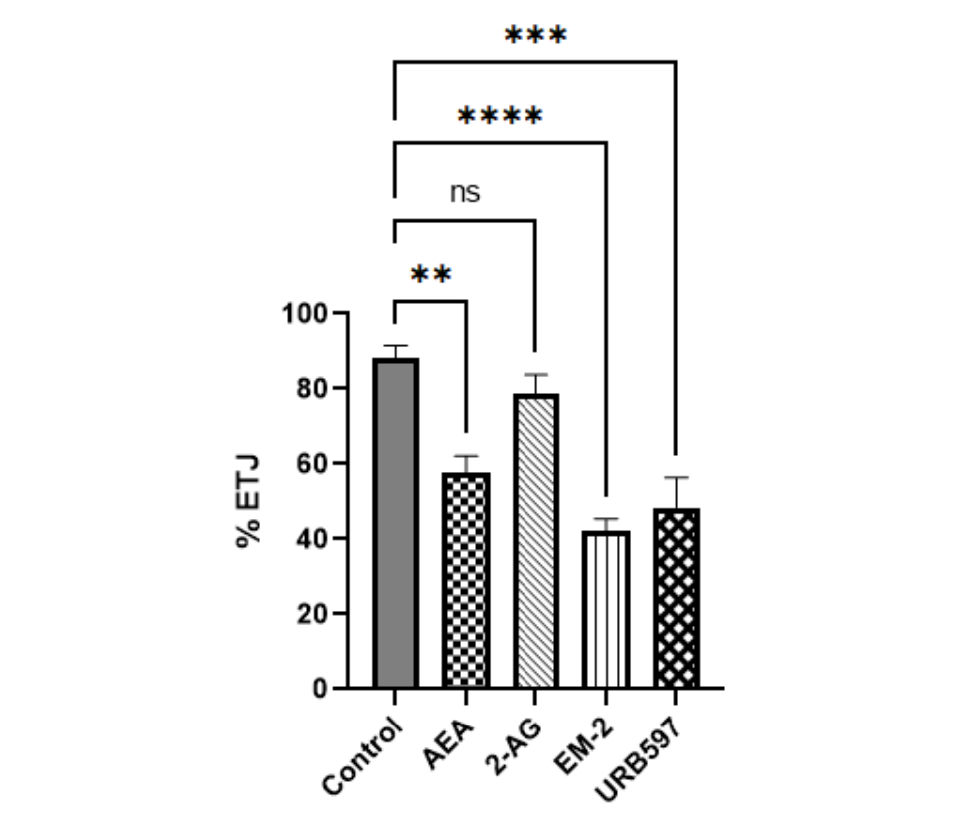
Figure 1. Effects of perfusion of cerebral ventricles with aCSF and with AEA, 2-AG, EM-2 and URB597 in rats on ETJ induced by tooth pulp stimulation. The data represent mean ± SEM of six rats per group. The highest amplitude of ETJ after i.c.v. perfusion with aCSF in control group was considered a 100% response. Statistical analyses were performed using one-way ANOVA and a post hoc multiple comparison Tukey test. Asterisks denote significance level (** p < 0.01, *** p < 0.001, **** p < 0.0001, ns — not statistically significant).